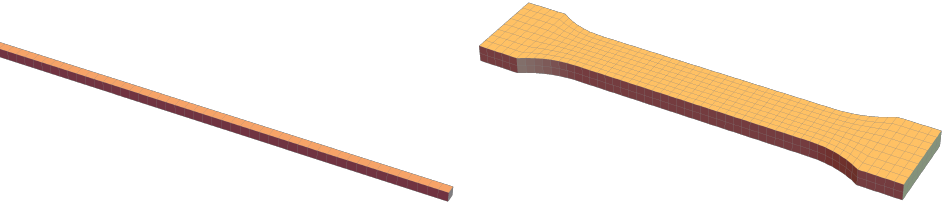
Figure 1. Geometry of samples and meshes, rod ( left ) and bone-shape sample ( right